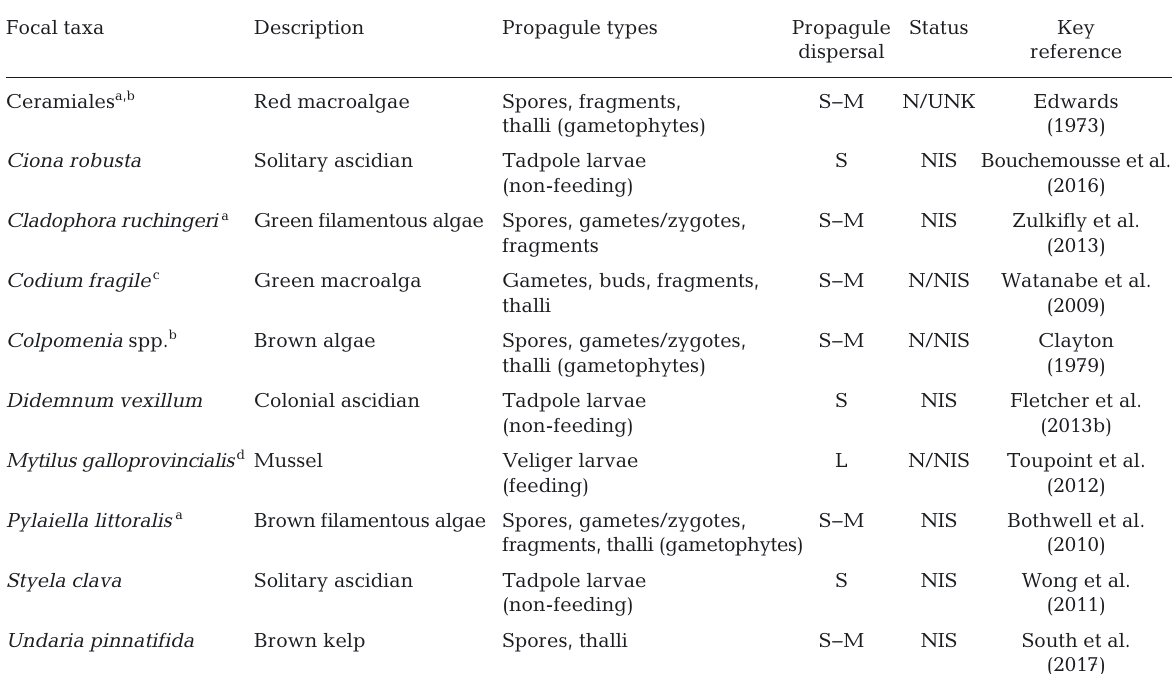
Table 1. Annotated list of focal taxa assessed during surveys of the Pelorus Sound region. Relative propagule dispersal distance: S = short; M = medium; L = long. Geographic origin in New Zealand recorded as: N = native; UNK =